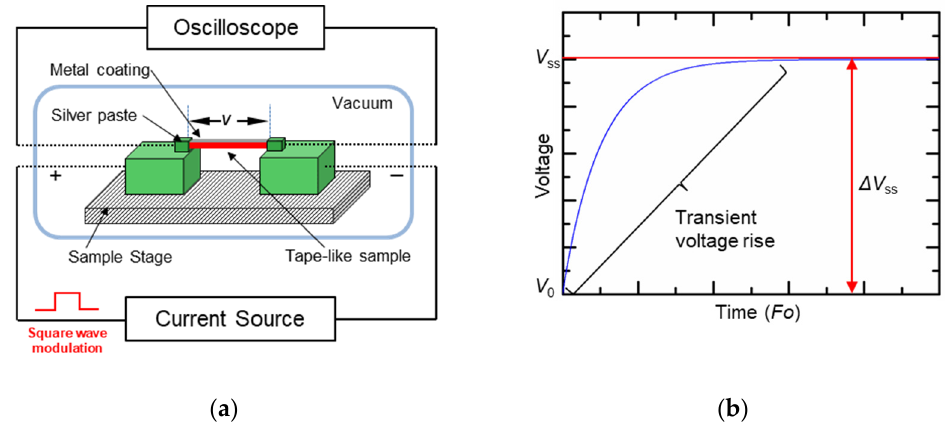
Figure 1. ( a ) Schematic of the experimental principle for the TET technique. ( b ) Voltage response to a step heating current through the sample.